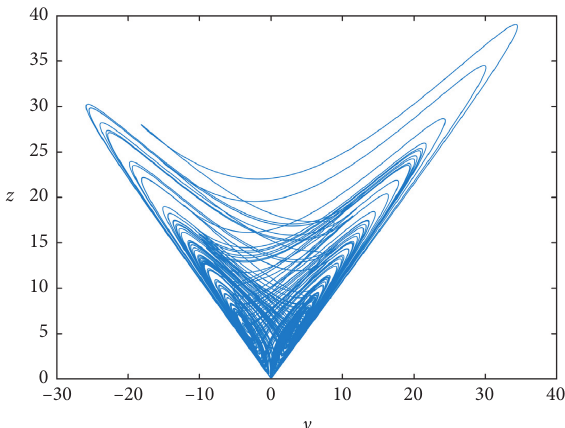
Figure 6: Dynamics of Lu et al.’s fractional-order system with the order α � 0 . 95, in context of y and z directions.